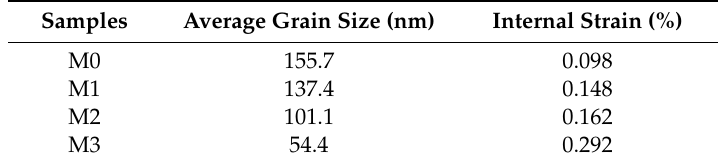
Table 2. Average grain size ( δ ) and internal strain ( ε ) of MPs with different ball-milling time.